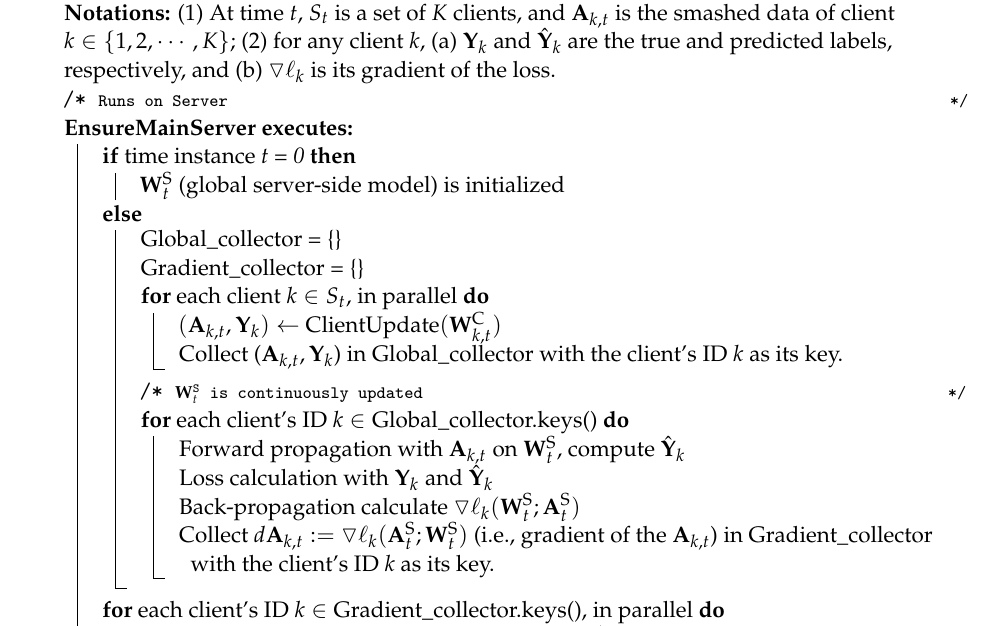
Algorithm 1: Multi-head split learning